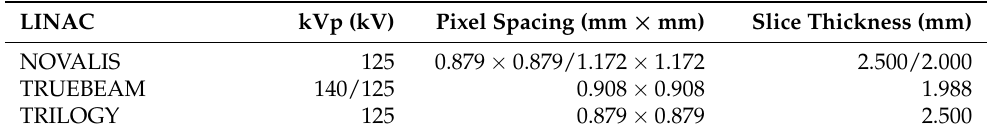
Table 1. Acquisition settings for CBCT.